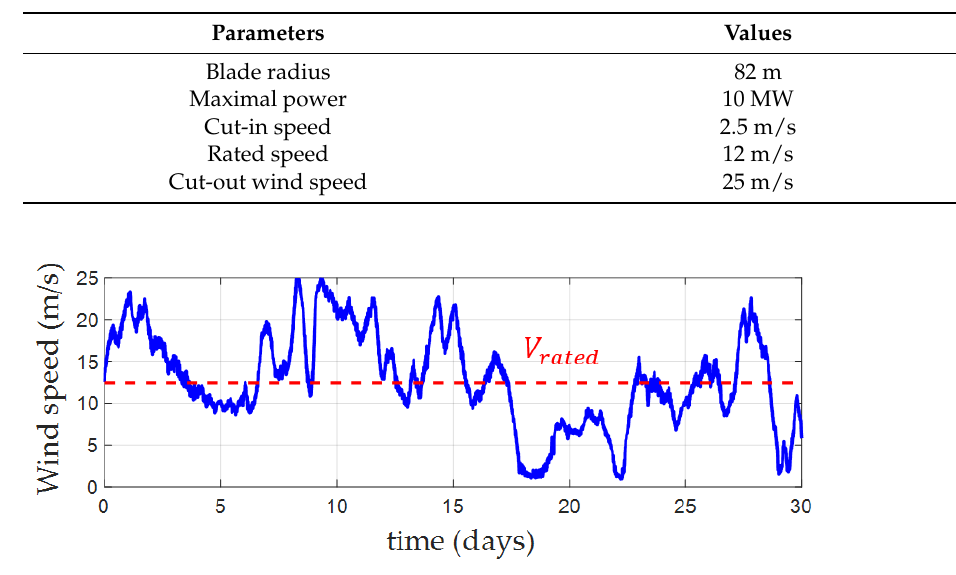
Figure 4. Wind speed profile measured at the North Sea in January. Table 1. Specifications of the considered wind turbine.